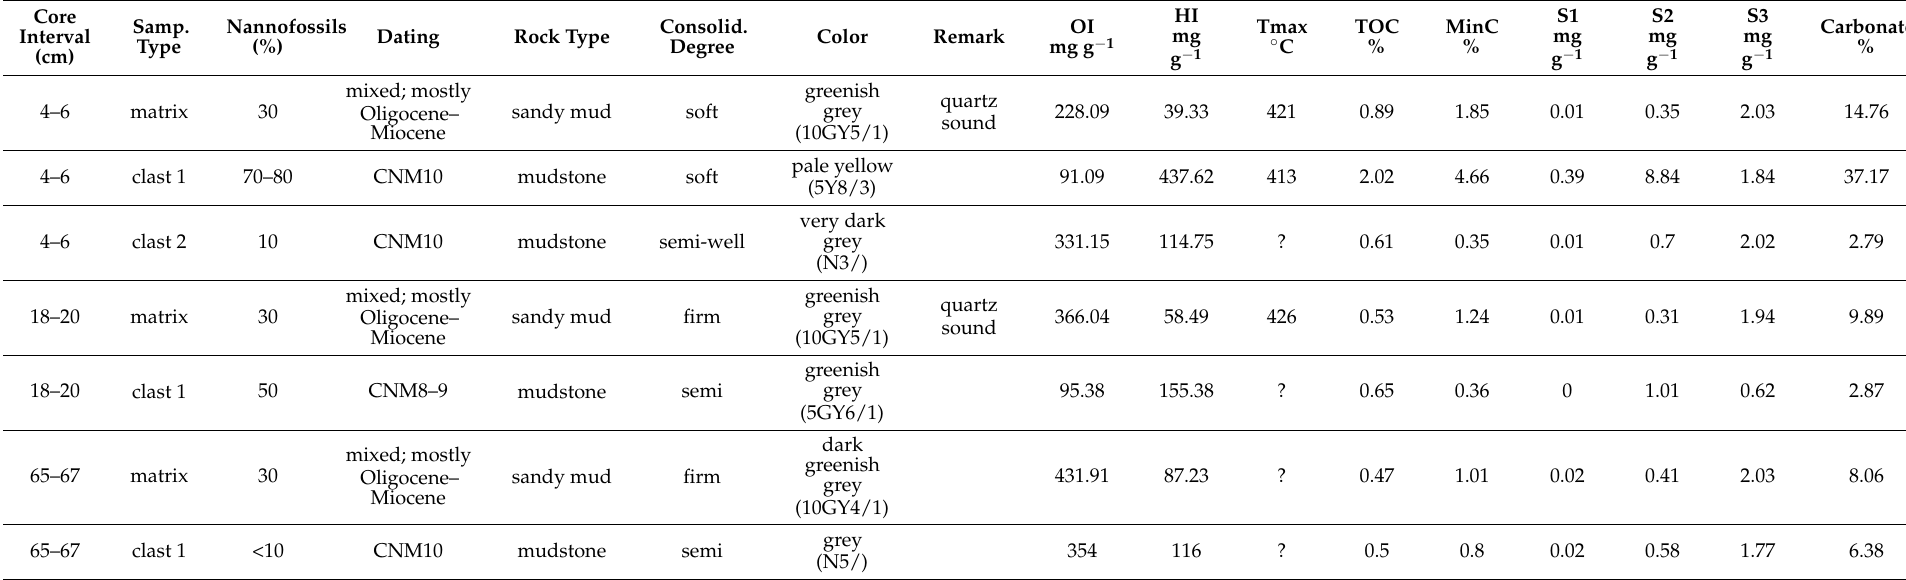
Table A1. Gelendzhik MV (LEV1GC core).